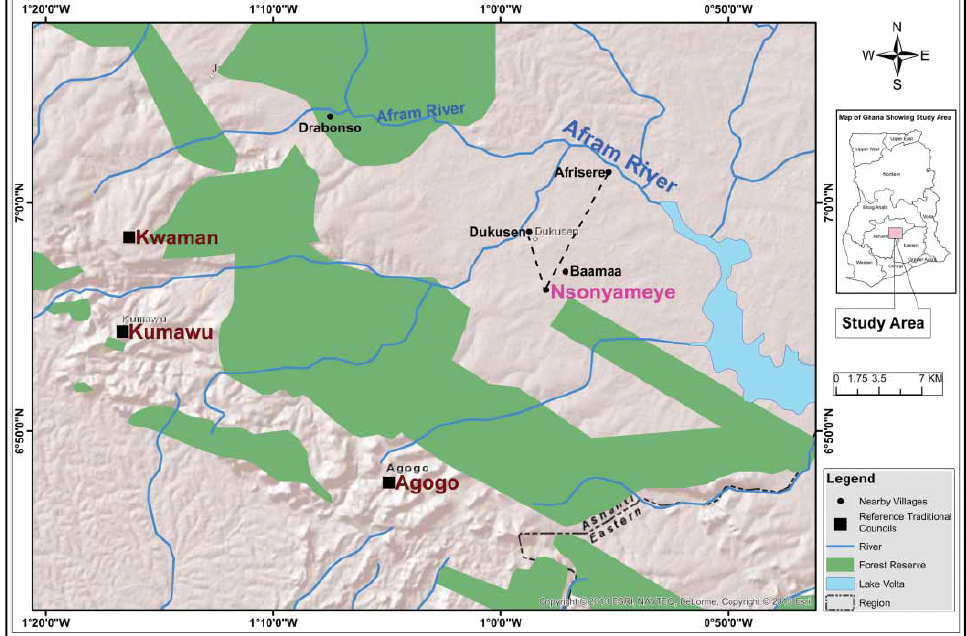
Figure 1. ScanFarm project showing studied communities in Ashanti-Akim North District. Source: Boamah [52].